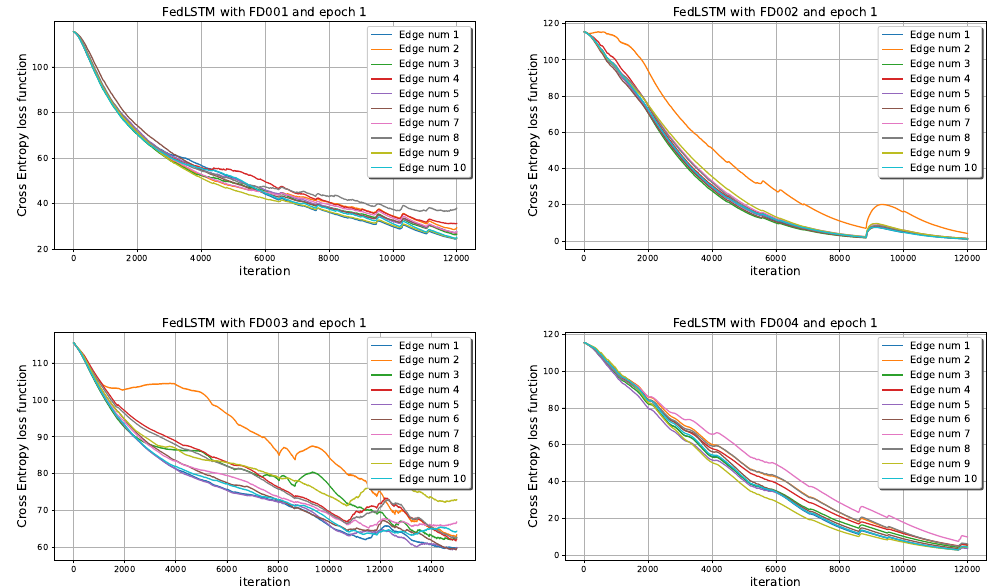
Figure 11. Convergence time of syncronous FedLSTM based on the communication of Figure 6.